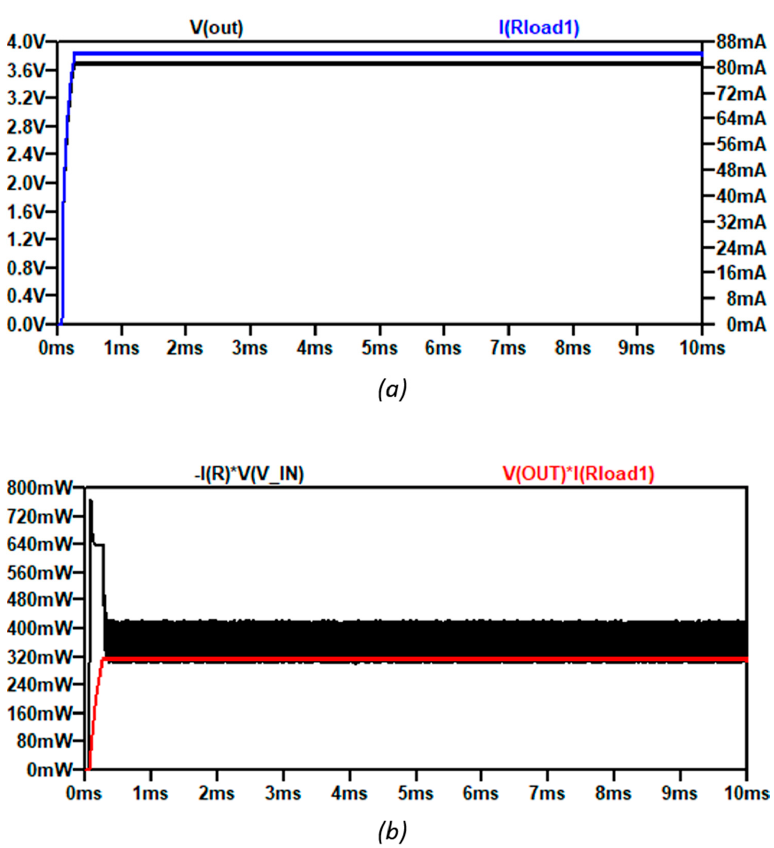
Figure 17. Simulation of TEH prototype for ∆ T = 27.8 K. ( a ) Output current (blue) and output voltage (black) ( b ) Input power (black) and output power (red).